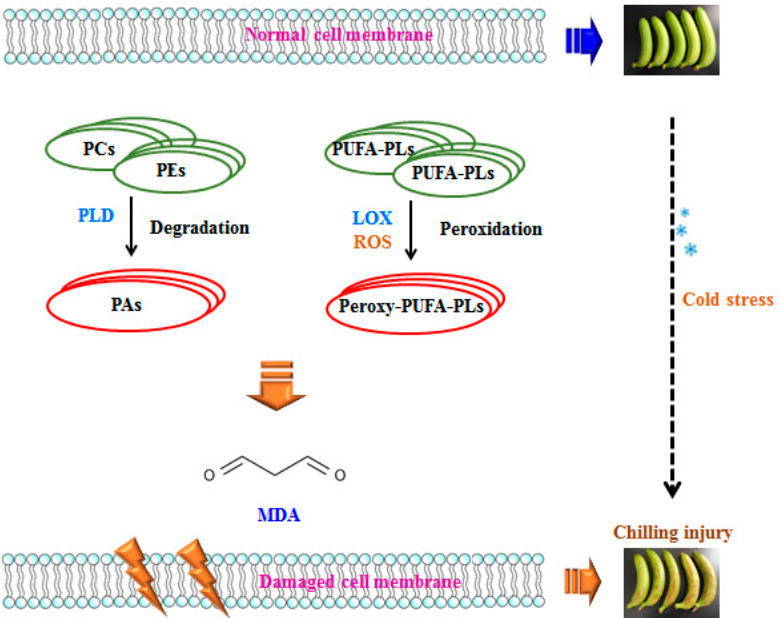
Figure 6. Probable mechanism of chilling injury of banana fruit based on membrane lipid metabolism. Phosphate group and hydrophobic chains of lipids are shown in sphere and line, respectively. PUFA: Polyunsaturated Fatty Acid; ROS: Reactive Oxygen